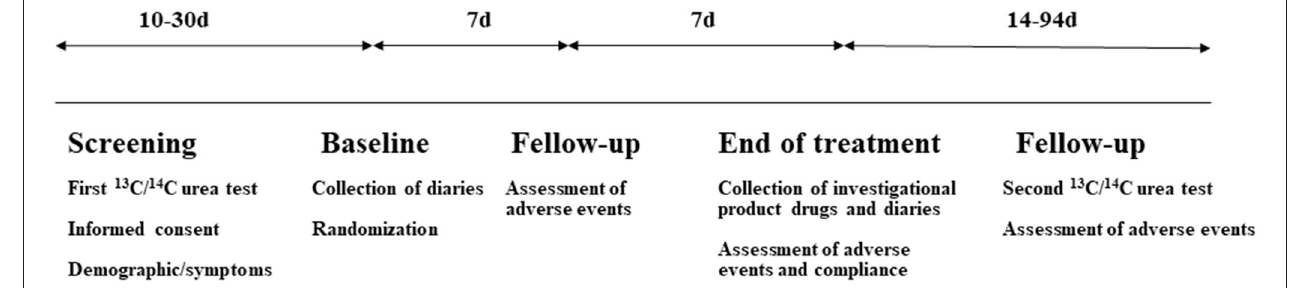
FIGURE 1 | Flowchart of the study